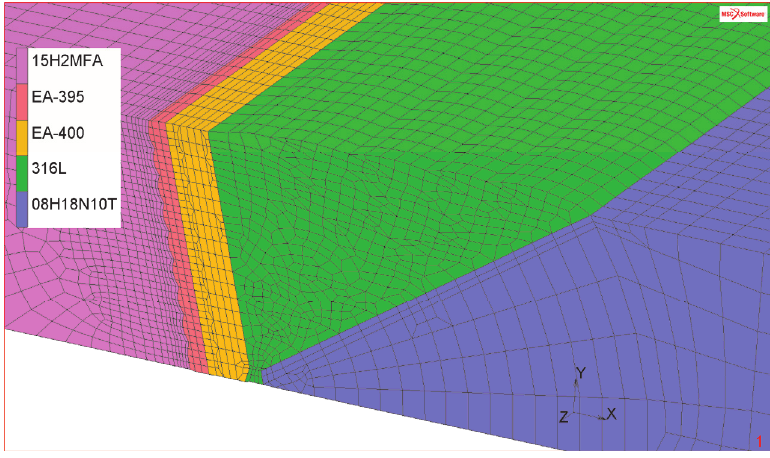
Figure 4: FE mesh for